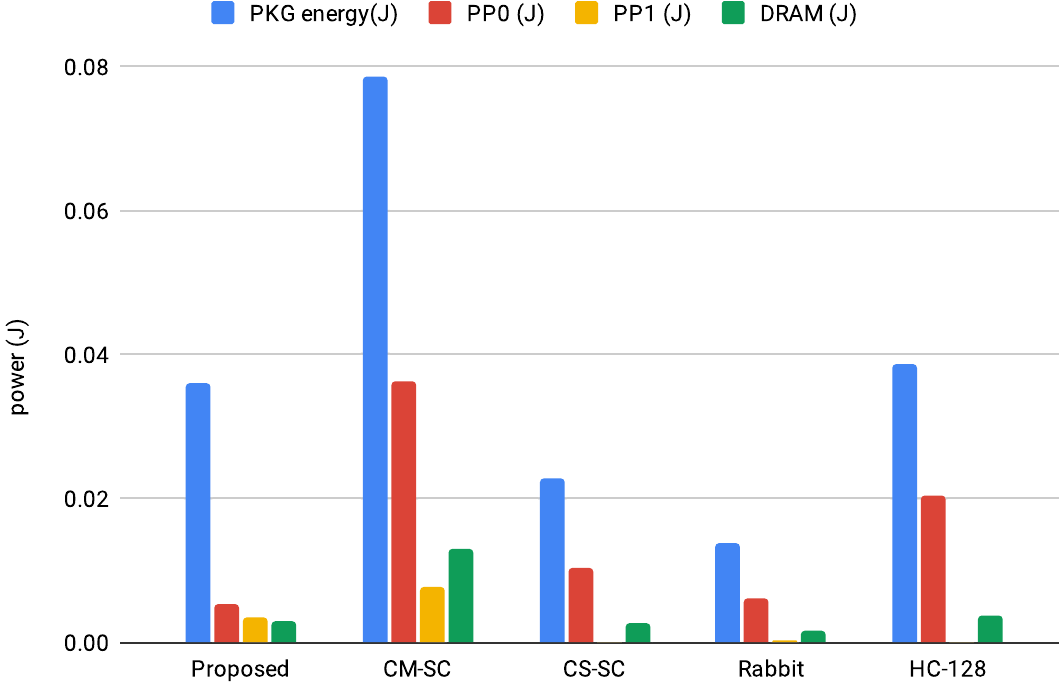
Figure 5. The comparison of the RAPL power consumption results.